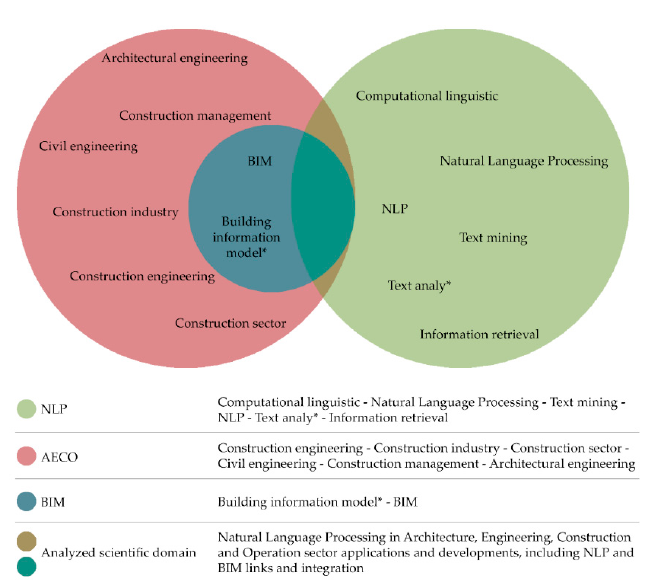
Figure 2. Visualization of research topics investigated.